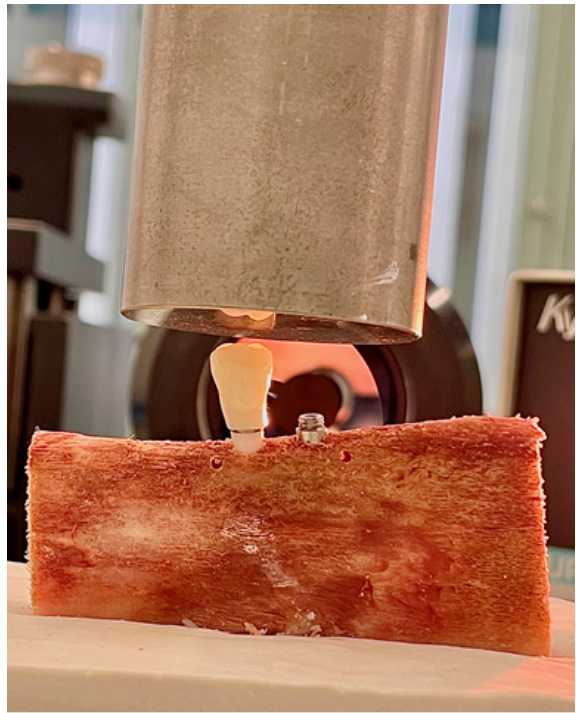
Figure 5. Detail of the PMMA crown screwed on the external hexagon of the Zr implant, and mount- ing on the MTS Bionix 358 test machine. In the background you can see the lens of the Questar QM- 100 long-distance microscope.